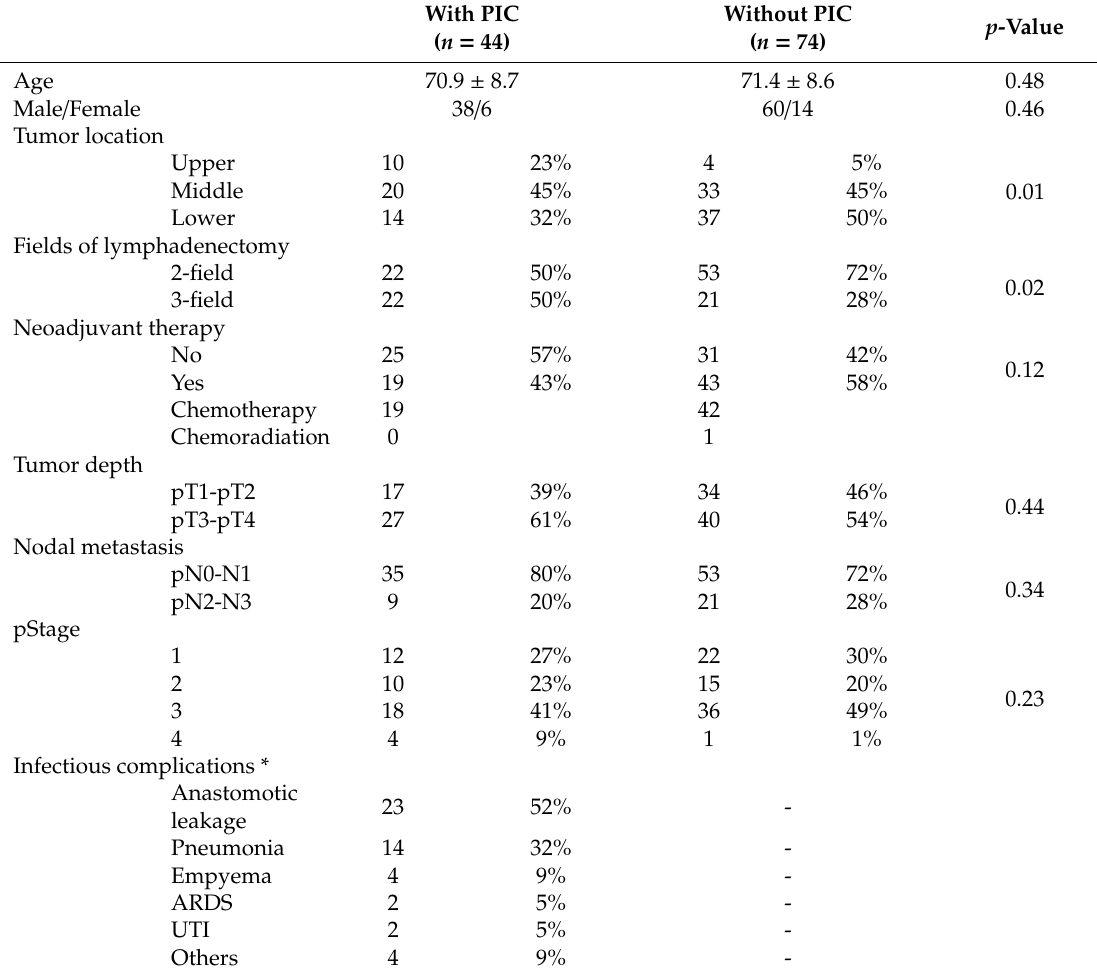
Table 2. Demographic data in patients with and without postoperative infectious complications.